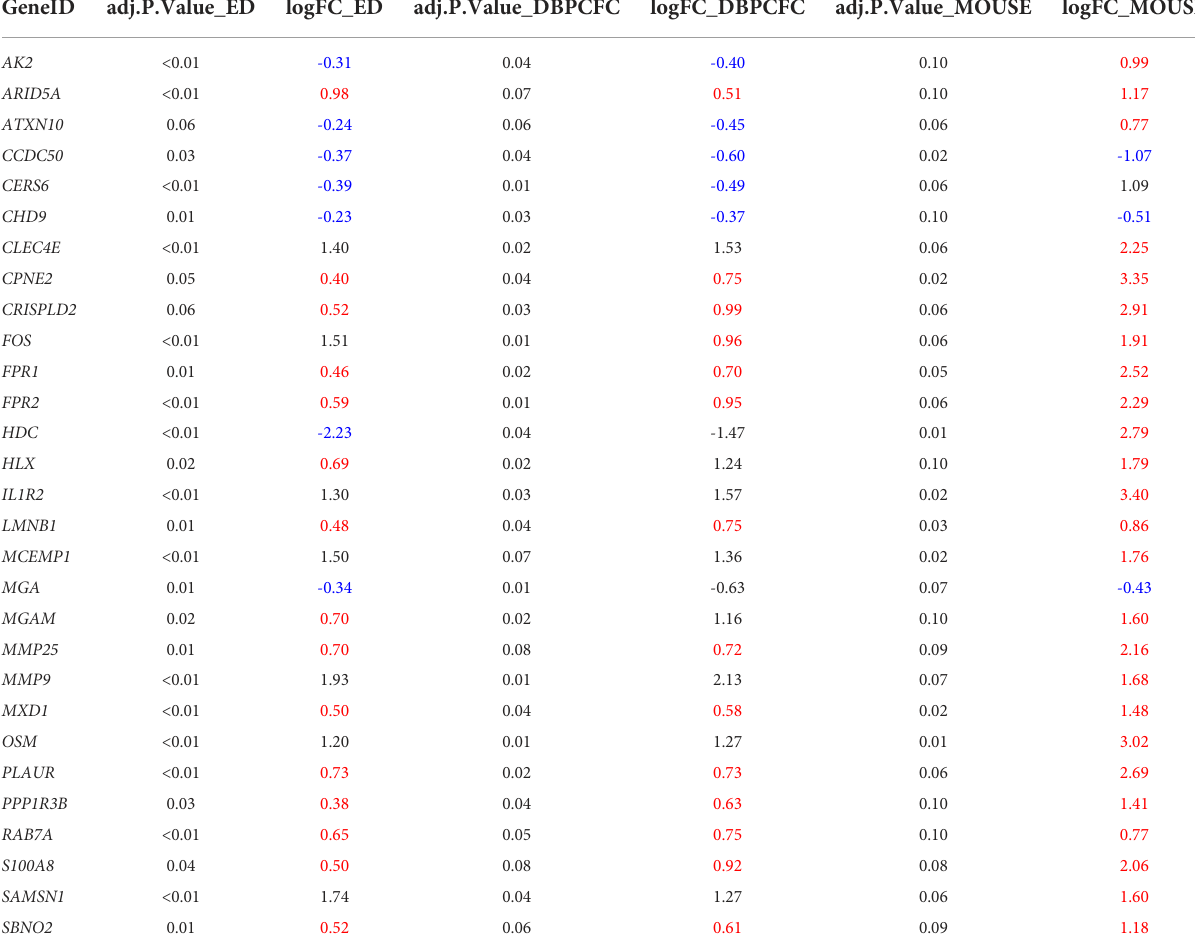
TABLE 4 Differentially expressed genes (q < 0.1) in all three study groups (human (ED and DBPCFC) and mouse study groups).